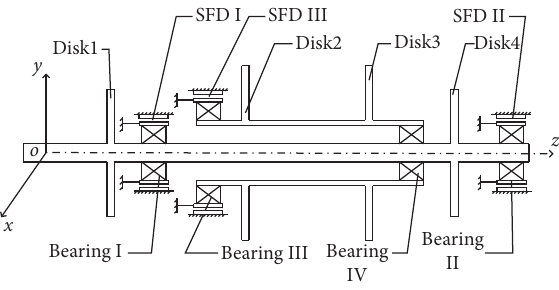
Figure 4: Schematic diagram of dual-rotor system. Table 1: Radial stiffness of the elastic supports.